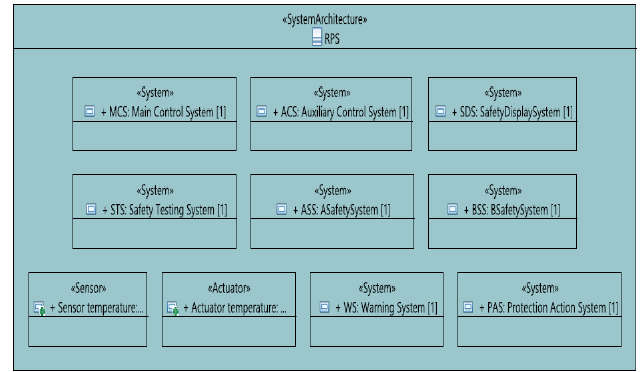
Fig.3- . RPS sub-systems, sensors and actuators.